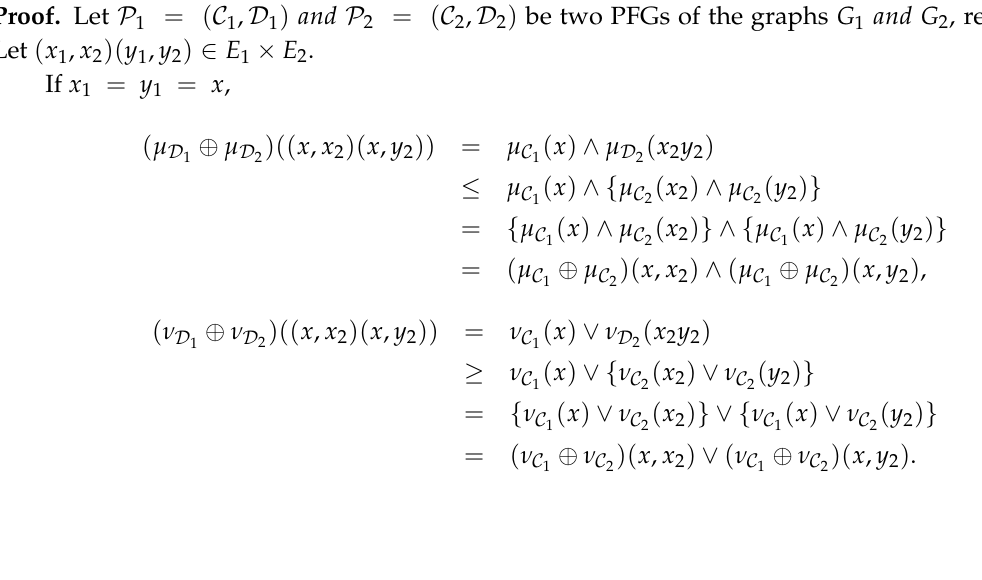
Figure 6. Symmetric difference of two Figure 2.5: Symmetric difference of two PFGs. Figure 2.5: Symmetric difference of two PFGs.